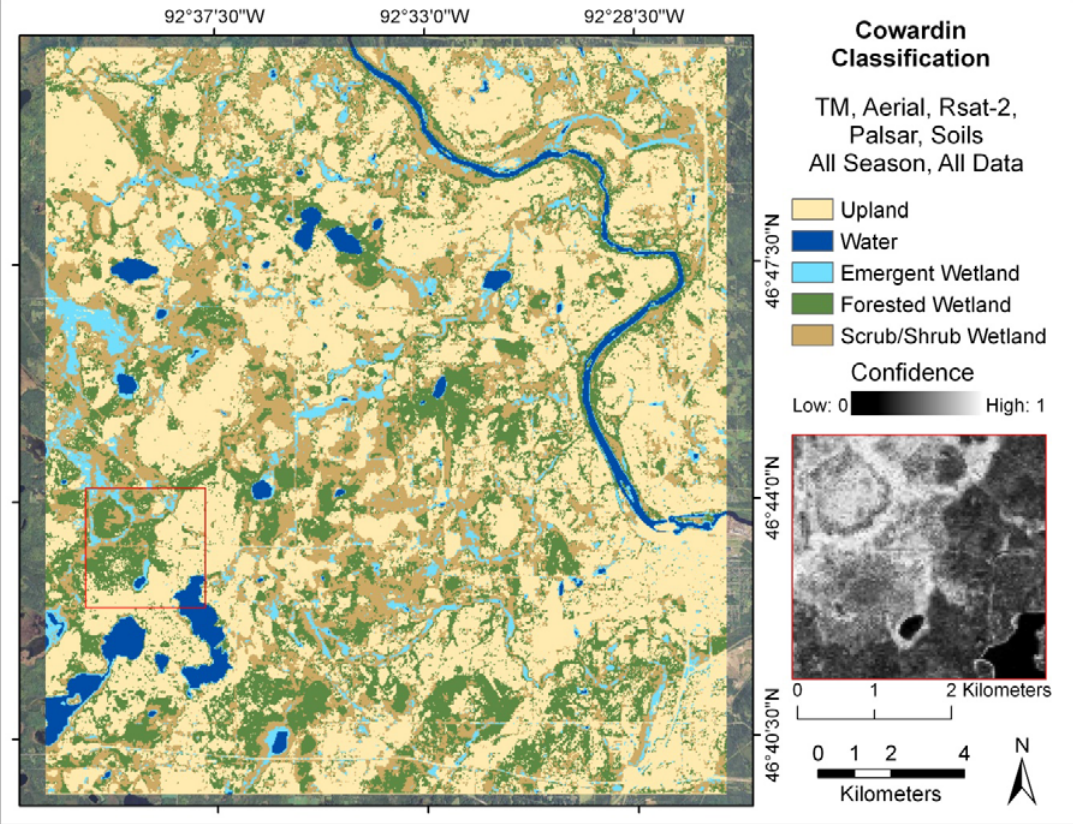
Figure 4. Output classification of the most accurate full season random forest model for the Level 2 land cover classification using all available Landsat 5 TM, aerial orthophoto, topographic, RADARSAT-2, PALSAR, and soils